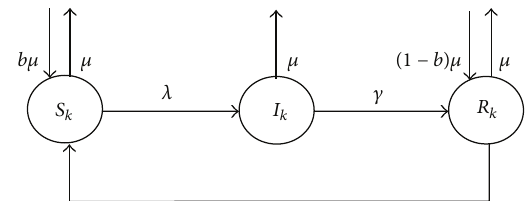
Figure 2: State transition graph of the 𝑘 th kind of nodes in M-SIR model.